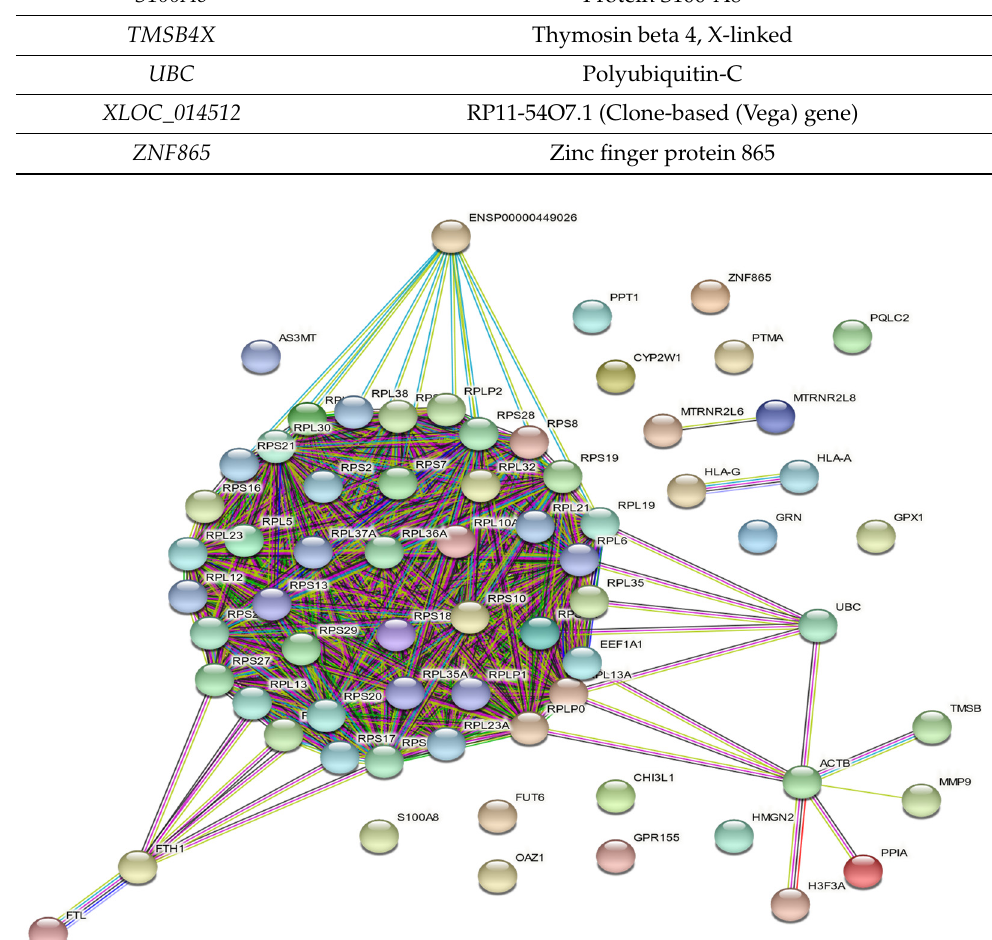
Figure 7. Network of gene-gene interactions in control and exposed SaOs-2 cells to 25 µg/mL of KNbO 3 salt as analyzed by String database v11.5. Sixty-eight retrieved genes were plotted as they were recognized in String DB©. The line color of network edges indicates the type of gene interaction evidence by: (i) database in light blue line, (ii) experimental in purple line, (iii) neighborhood in green line, (iv) fusion in red line (evidence), (v) co-occurrence in blue line, (vi) text mining in yellow line, (vii) black line (co-expression evidence) and, finally, (viii) protein homology in